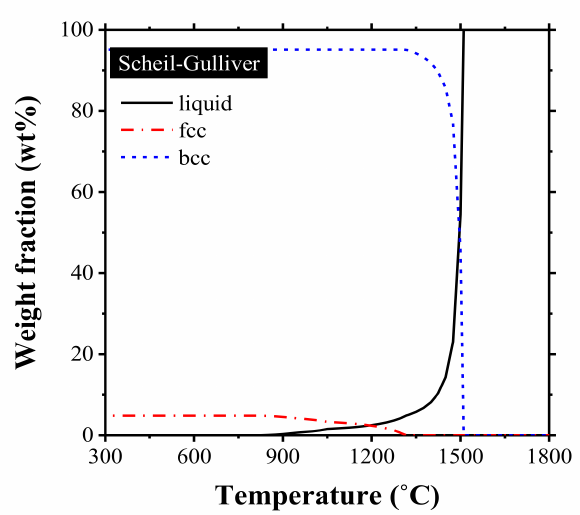
Figure 3. SEM images of specimen that ruptured at the HAZ. Specimen was prepared using a laser power of 4 kW and a welding speed of 10 m/min using a 450-mm focusing optic system: magnification is ( a ) 1000 × and ( b ) 5000 × .